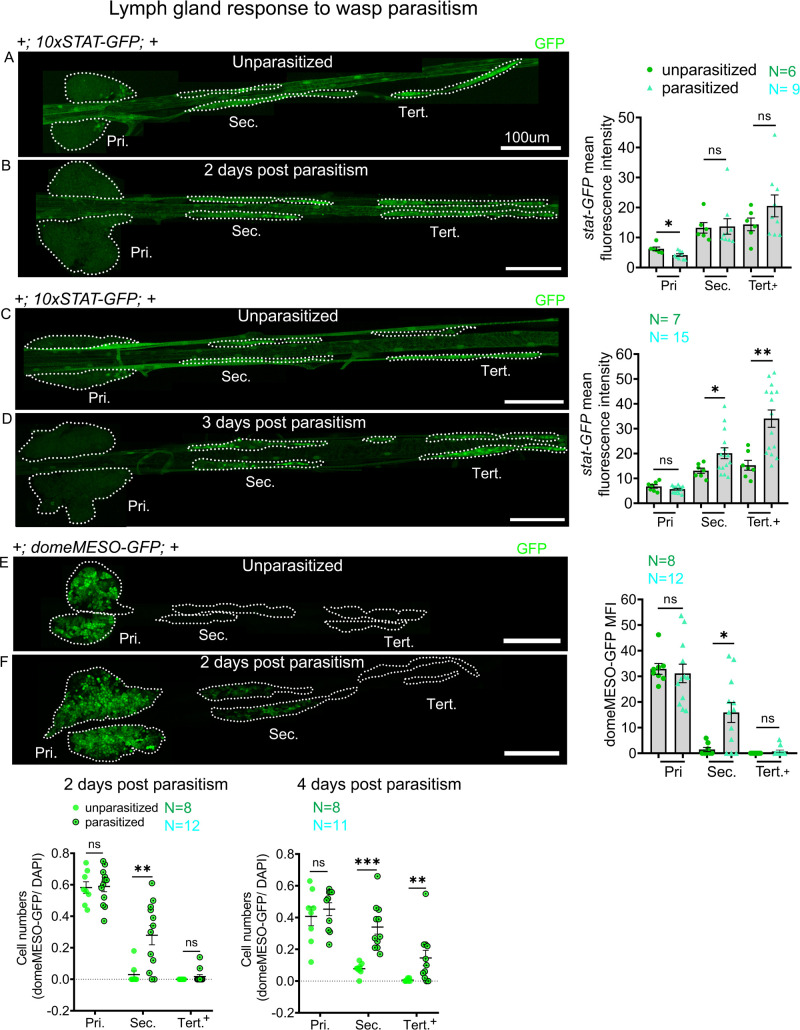
JAK-STAT reporter activity in response to wasp parasitism.JAK-STAT activity is monitored using 10xSTAT-GFP (A–D) and domeMESO-GFP (E and F) reporter. Reporter activity in the lymph gland lobes is compared and quantified between age-matched unparasitized and parasitized larvae at the indicated time points. (A and B) 2 days post-parasitism 10xSTAT-GFP reporter activity (green) decreases in the primary lobes and remains unchanged in the posterior lobes. (C and D) 3 days post-parasitism 10xSTAT-GFP activity (green) increases in the posterior lobes. Graphs representing the mean fluorescence intensity (MFI) for 10xSTAT-GFP are plotted for each time point. (E and F) 2 days post-parasitism domeMESO-GFP reporter activity (green) remains unchanged in the primary lobes and the tertiary lobes but increases in the secondary lobes. Graphs representing ratio of domeMESO-GFP+/DAPI+ cells and MFI are plotted. Mann–Whitney nonparametric test was used for statistical analysis and error bars represent SEM. *p<0.05, **p<0.01, ***p<0.001, and ns indicates nonsignificant. Pri. indicates primary lobes, Sec. indicates secondary lobes, and Tert. indicates tertiary lobes. (A–F) Scale bar: 100 µm.Figure 5—figure supplement 1—source data 1.Numerical data plotted and statistical analysis related to Figure 5—figure supplement 1.